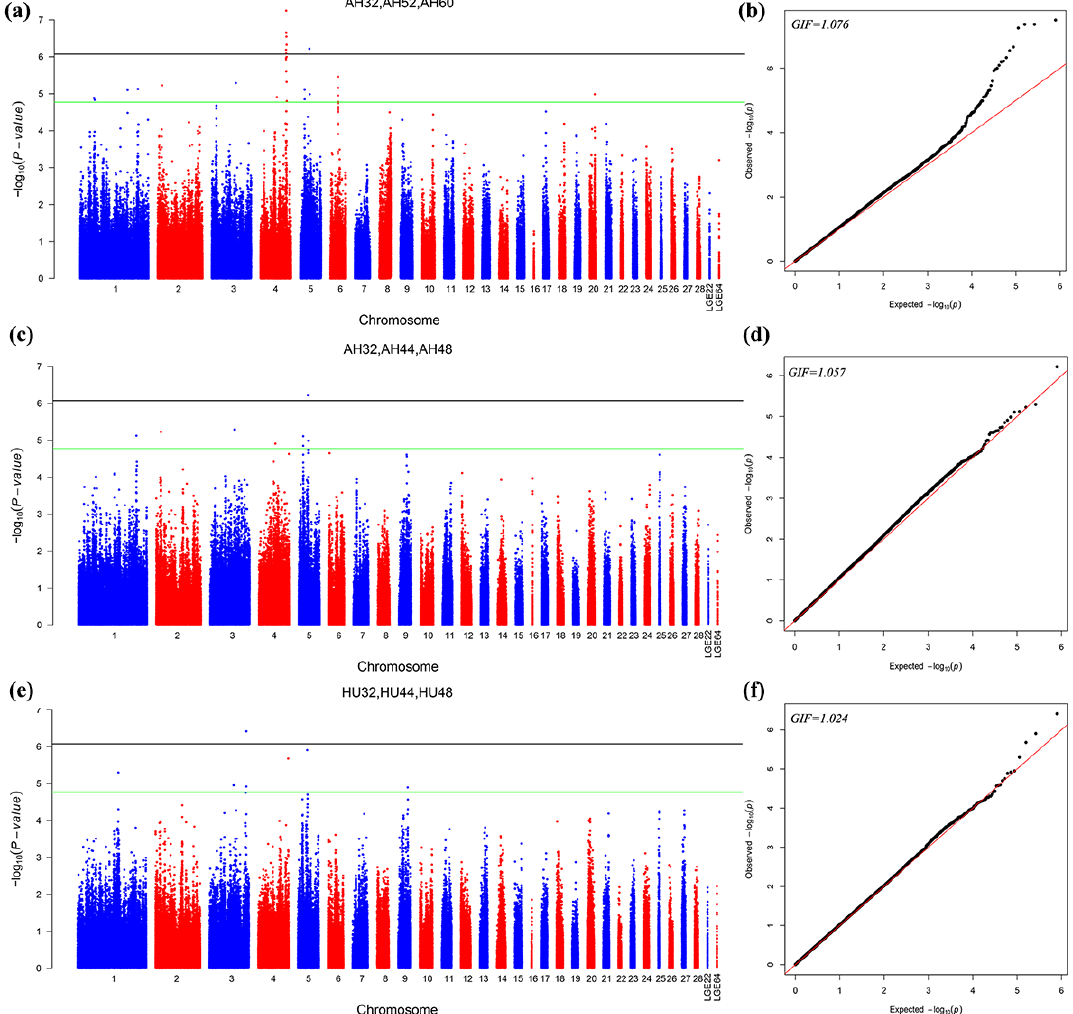
Figure 2. Manhattan plot (a, c, e) and quantile–quantile (Q–Q) plot (b, d, f) of the observed P values for the albumen quality by multivariate analysis. For the Manhattan plots, the black line and green lines are the genome-wide significant and suggestive thresholds with values of 8 . 43 × 10 − 7 and 1 . 69 × 10 − 5 ,